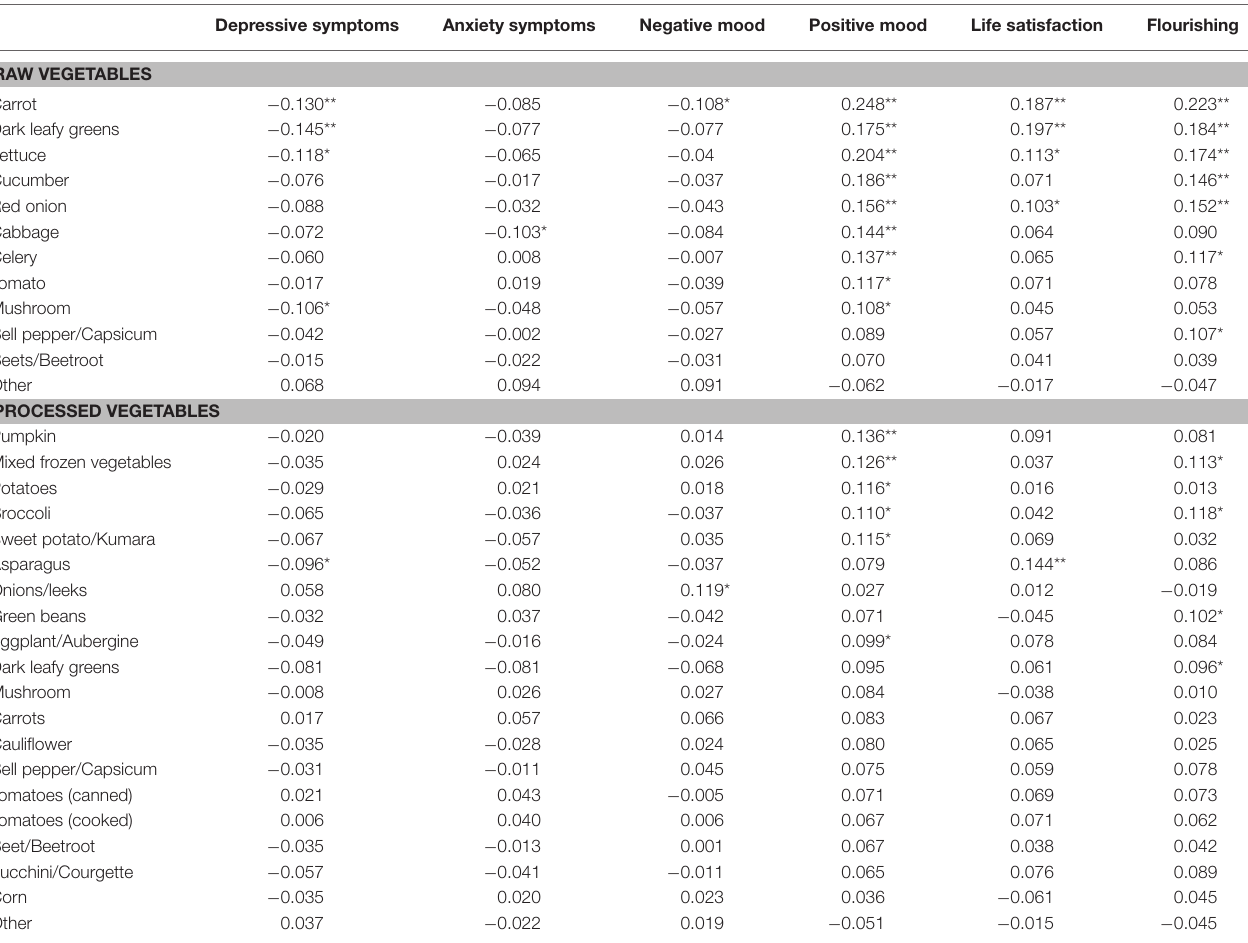
TABLE 6 | Correlations between types of raw and processed vegetables, and mental health. Depressive symptoms Anxiety